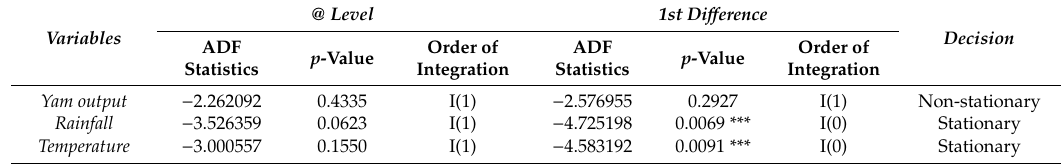
Table 1. Results of unit root test from the Augmented Dickey–Fuller